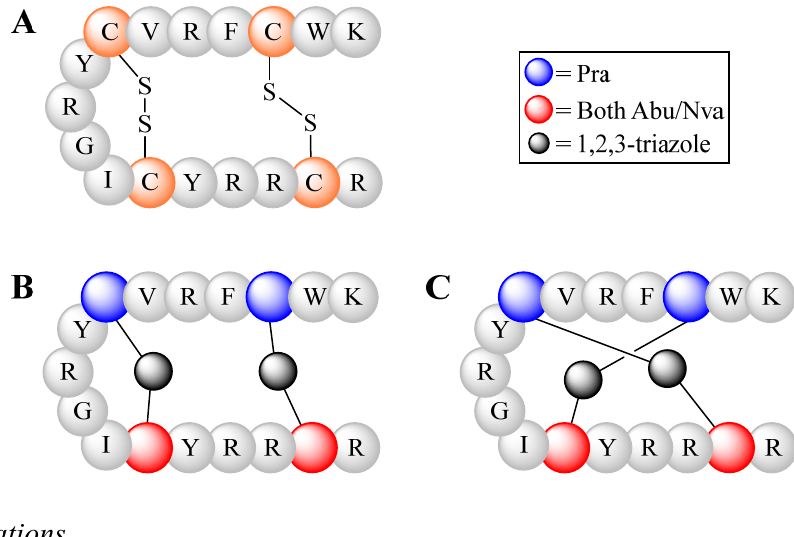
Figure 16. β -Hairpin structure of TP-1 peptide (in single letter amino acid code). ( A ) Native structure with two disulfide bonds. ( B ) Hairpin-like structure via triazole linkers. ( C ) Globule-like structure due to incorrect folding.